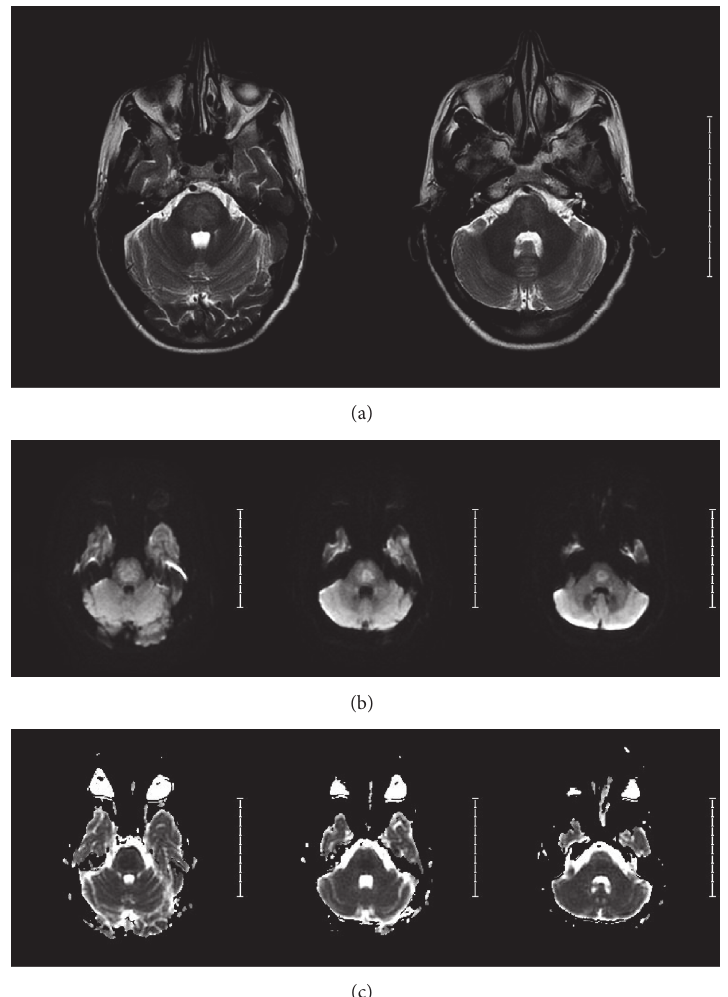
Figure 5: MRI with and without contrast on hospital day 15. T2-weighted MRI shows mild diffuse hyperintense signal changes in the pons (a); DWI sequence shows restricted diffusion (b) with corresponding ADC hypointensity (c) in central pons. These findings were not present when compared to MRI on hospital day 5 (Figure 3) and are consistent with central pontine